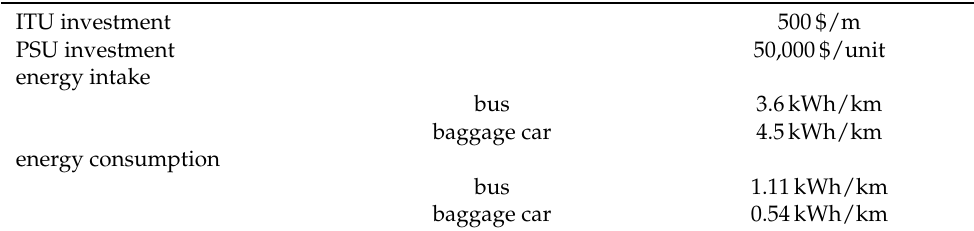
Table 2. Parameter values for test instances.